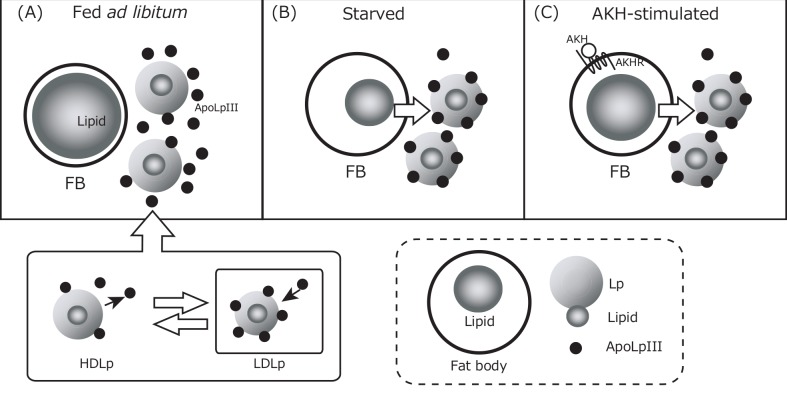
Schematic models to maintain the hemolymph lipid level.(A) For crickets feeding normally, the hemolymph lipid level is maintained by shuttling between HDLp to LDLp; however, the hemolymph lipid level was maintained at similar levels even in GrybiApoLp-III knockdown crickets. (B) For long-term starved crickets, the lowered hemolymph lipid level was recovered from the fat body lipids via LDLp. (C) For AKH-stimulated crickets, possibly under the condition of acute lipid requirements, hemolymph lipid levels increase by lipids of the fat body via LDLp by AKH stimulation.